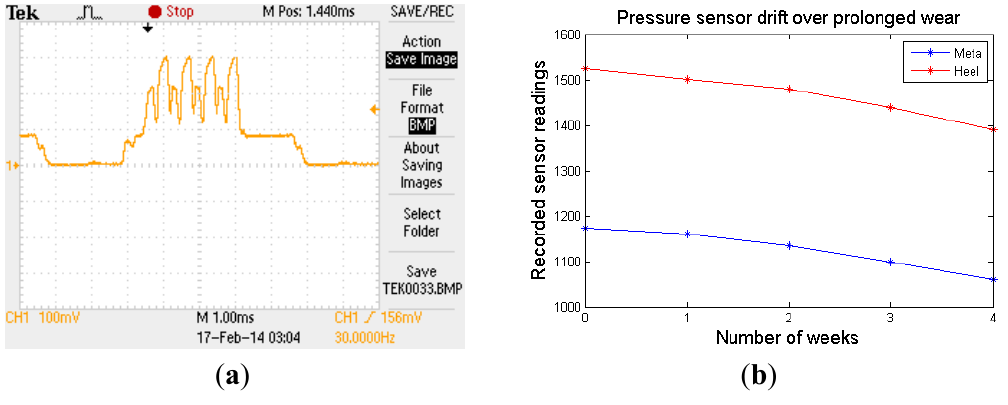
Figure 7. ( a ) Scope trace for connection event; ( b ) pressure sensor readings plot displaying the drift.